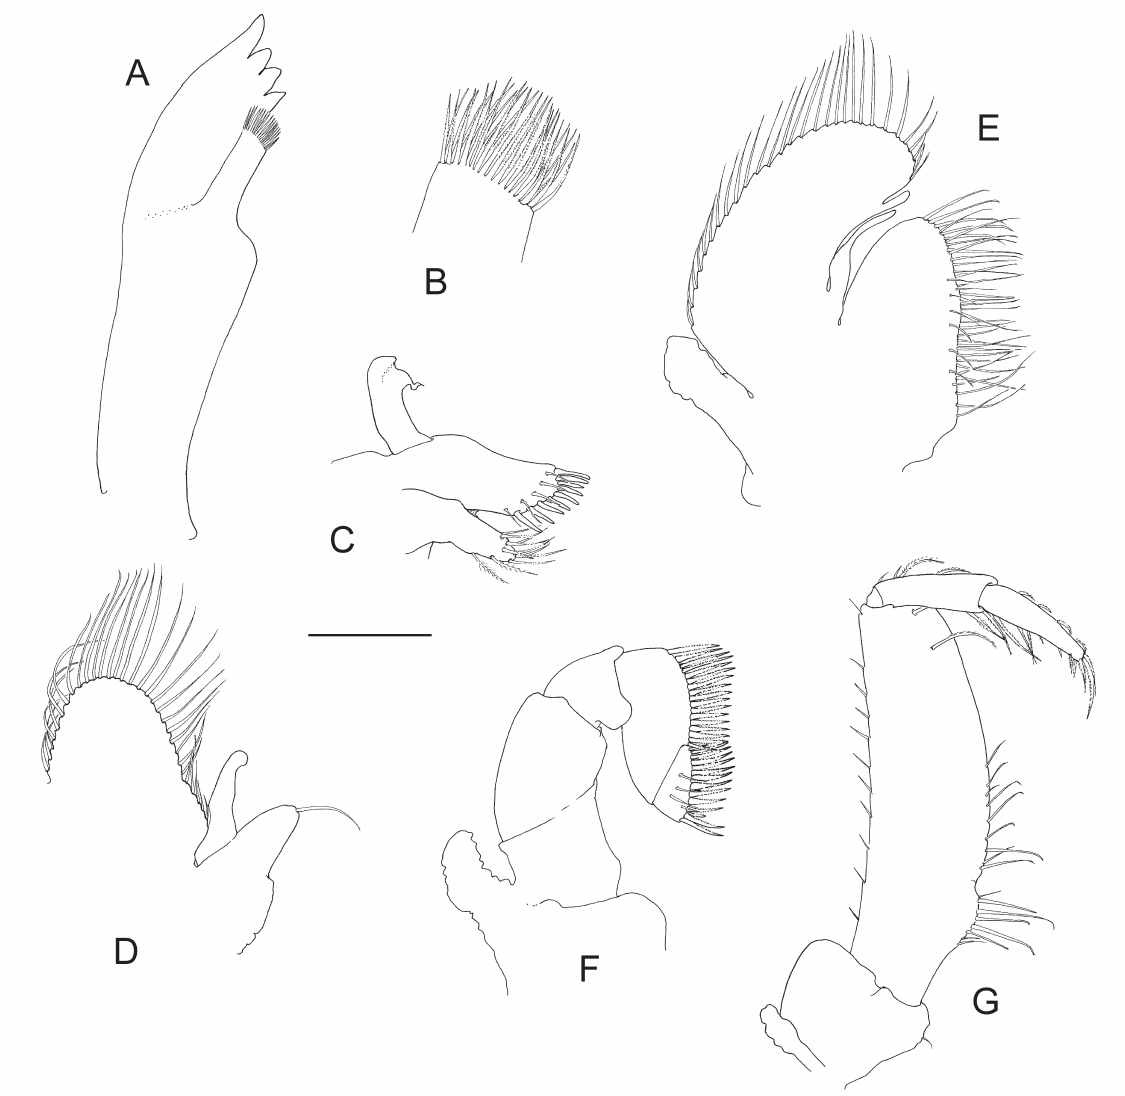
Fig. 8. Hamodactylus pseudaqabai sp. nov., ovigerous ♀ , paratype (PoCL 2.2 mm, Sabah, Malaysia, RMNH.CRUS.D.53969), mouthparts. A . Left mandible, ventral view. B . Same as previous, detail of molar process. C . Right maxillula, ventral view. D . Right maxilla, ventral view, posterior lobe of scaphognathite lost in dissection. E . Right first maxilliped, ventral view. F . Right second maxilliped, ventral view. G . Right third maxilliped, ventral view. Scale bars: A, C-G = 1 mm; B = 0.25